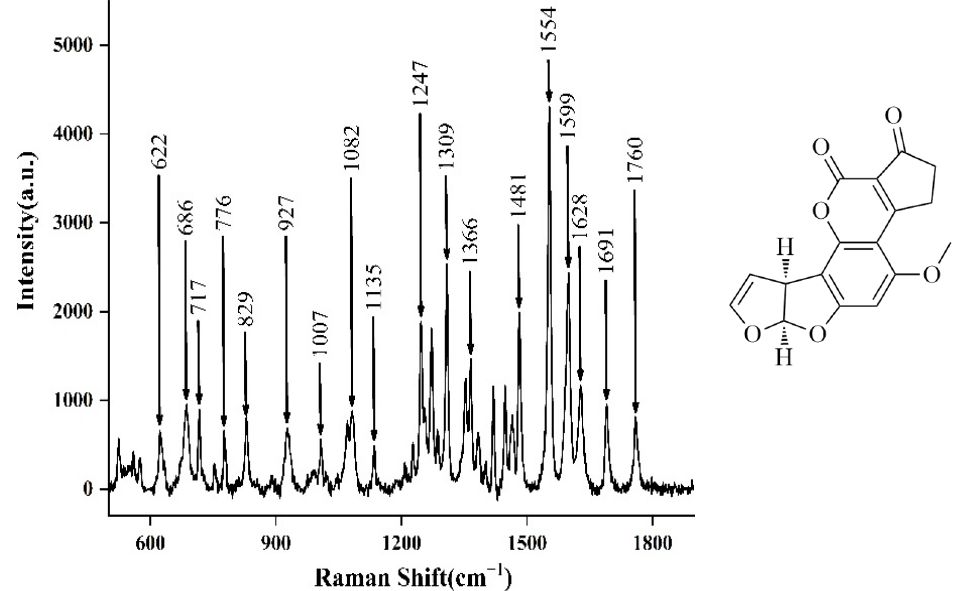
Figure 9. Raman spectrum of aflatoxin B 1 solid powder determined by laser confocal micro Raman spectrometer.